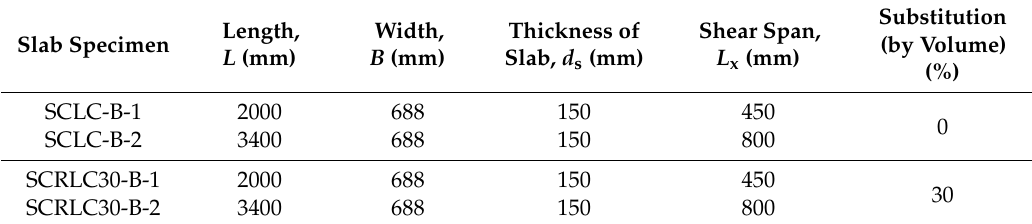
Table 4. Dimensions of composite slab specimens.